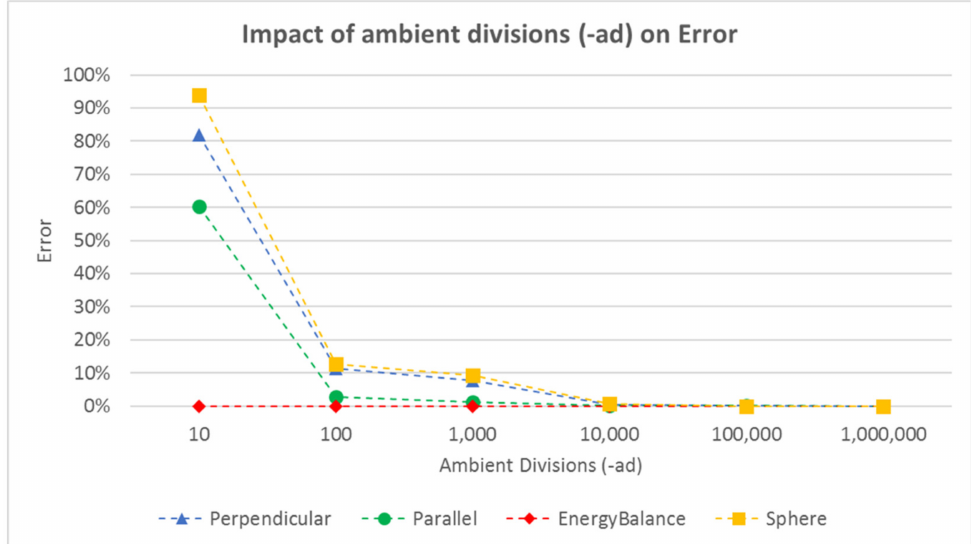
Figure 18. The variation in average error as per ambient divisions for the calculations considered in Section 3.1 (Parallel), Section 3.2 (Perpendicular), Section 3.3 (Sphere) and Section 3.4 (EnergyBalance).